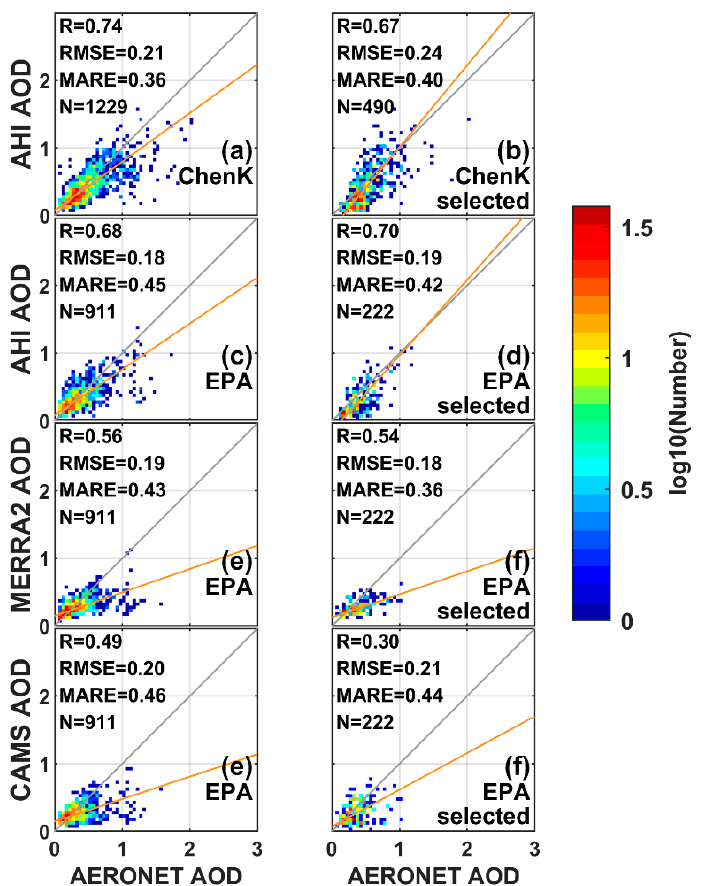
Figure 4. Scatterplots of AHI, MERRA-2, and CAMS AOD versus AERONET AOD in Chen_Kung_Univ and EPA_NCU sites; ( a – d ) represents the accuracy of AHI AOD datasets in Chen_kung_Univ and EPA_NCU with full matchups and selected matchups only including land pixels, ( e – f ) reanalysis AOD datasets. Columns 1 and 2 indicate the evaluation results of matchups with near-water pixels involved and excluded, respectively.